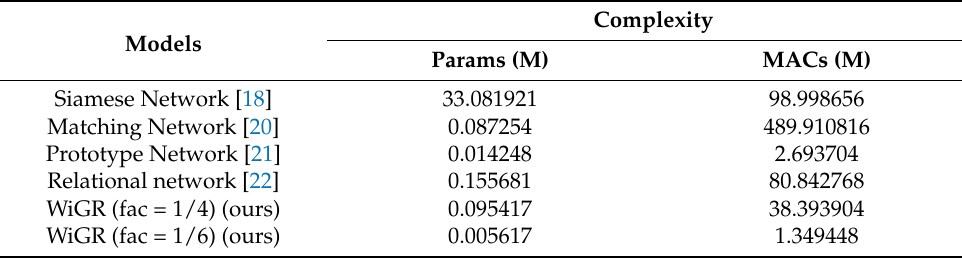
Table 7. Models’ complexity performance.